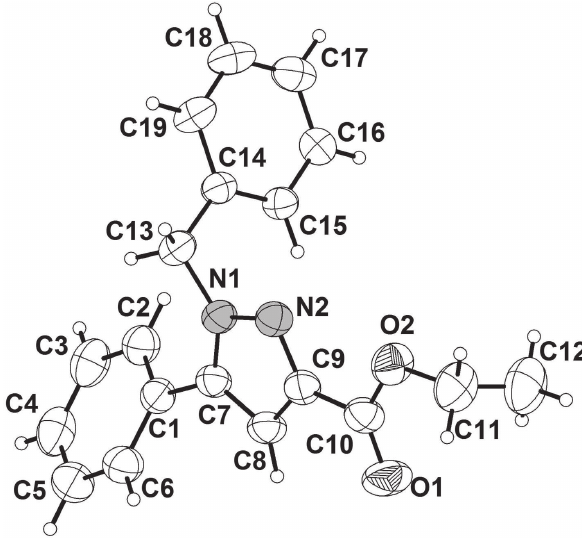
Table 1: Data collection and